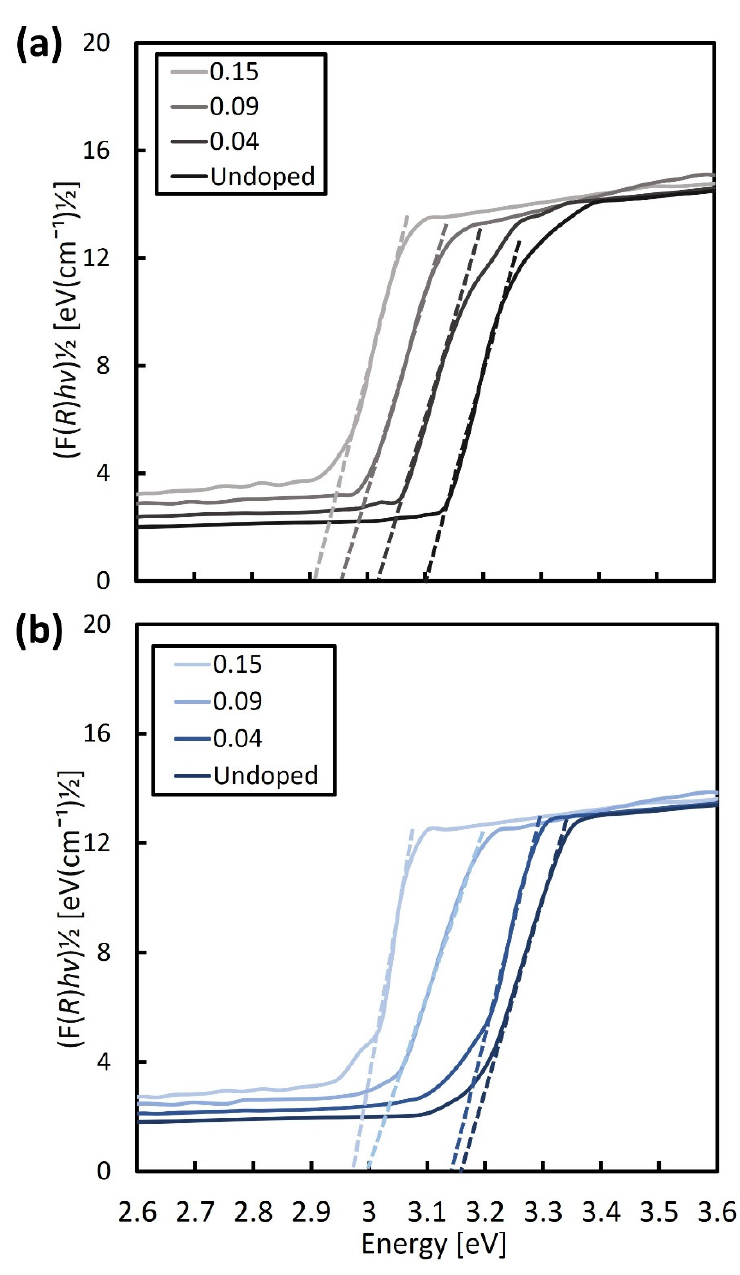
Figure 4. Kubelka–Munk function as a function of photon energy for ( a ) NR and ( b ) NRFs samples with additions of 0 (undoped), 0.04, 0.09, and 0.15 wt.% of AgNO 3 . The broken lines were shown to intercept the phonon-energy axis for assessing the band-gap energy of NR and NRFs samples.